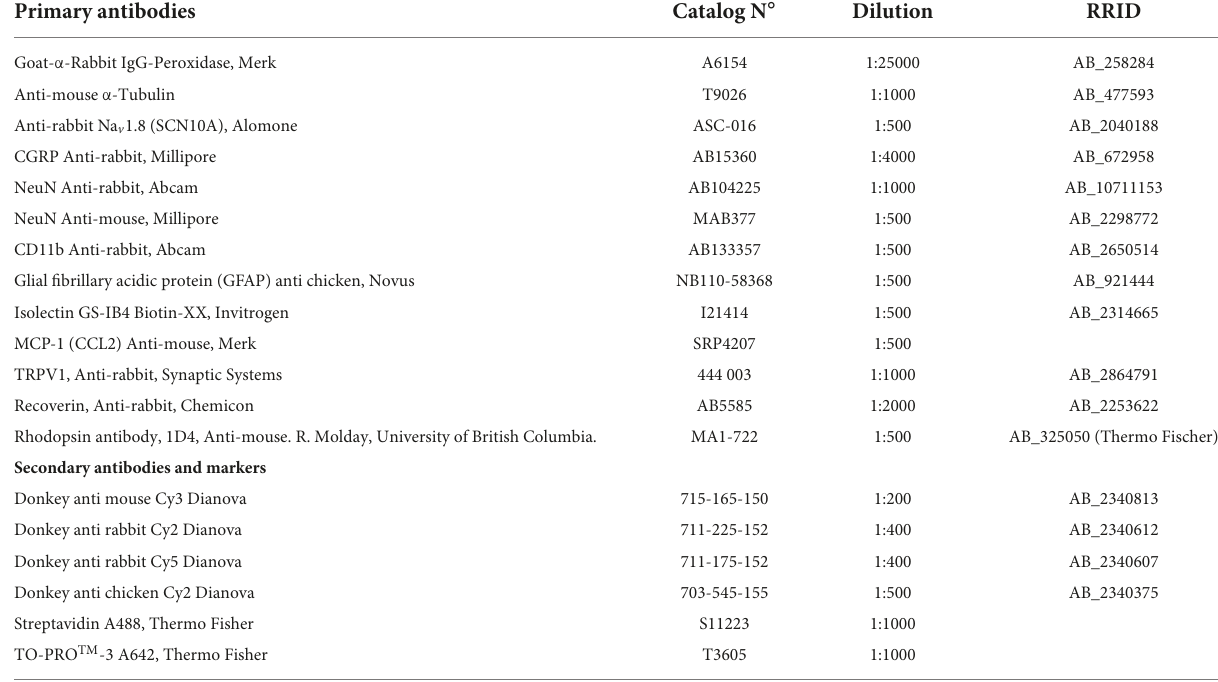
TABLE 2 List of antibodies used in immunohistochemistry and Western blot experiments. Primary antibodies Catalog N ◦